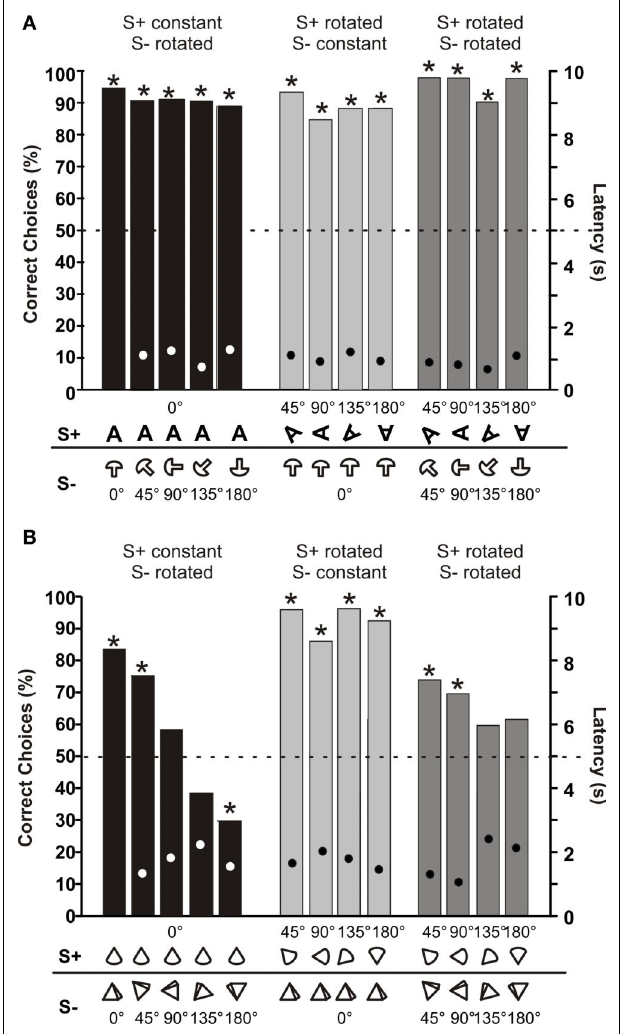
FIGURE 6 | (A) Mean choice frequencies of fi sh 4, which was trained to discriminate between a 3-dimensional A (S + ) and a mushroom (S − ), symbols of which showing the rotation angle are given below each bar along the abscissa. Both objects were rotated by various angles (numbers above symbols). (B) Mean choice frequencies with rotated objects of fi sh 5, which was trained to discriminate between a cone (S + ) and a pyramid (S − ). Dots within each column give mean choice latencies (right ordinate). N ≥ 50.